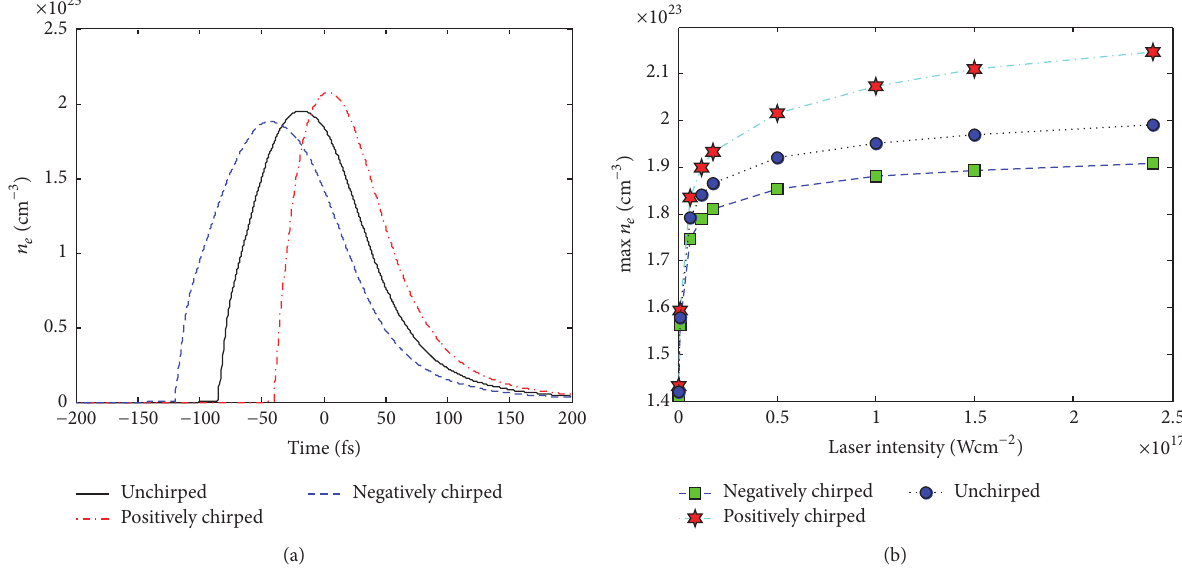
Figure 3: (a) Time evolution of the electron density with 1 × 10 17 Wcm −2 laser intensity, 40 fs duration pulse, and wavelength of 825 nm. (b) The variations in the maximum electron density at the different laser pulse shapes in different laser intensities with 40 fs duration pulse and wavelength of 825